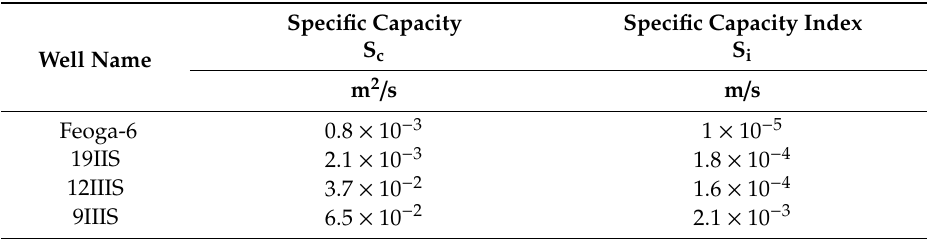
Table 7. Specific capacity and specific capacity index